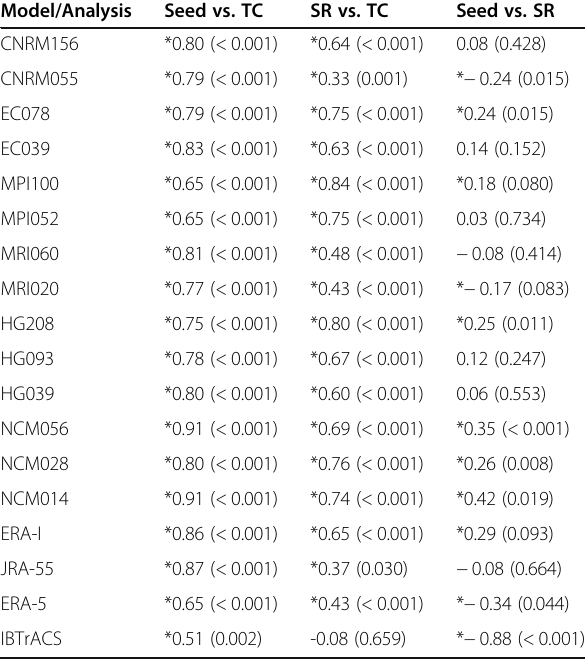
Table 5 Spearman ’ s rank correlations between TC genesis frequency, TC seed frequency, and survival rate (SR) in each model and reanalysis